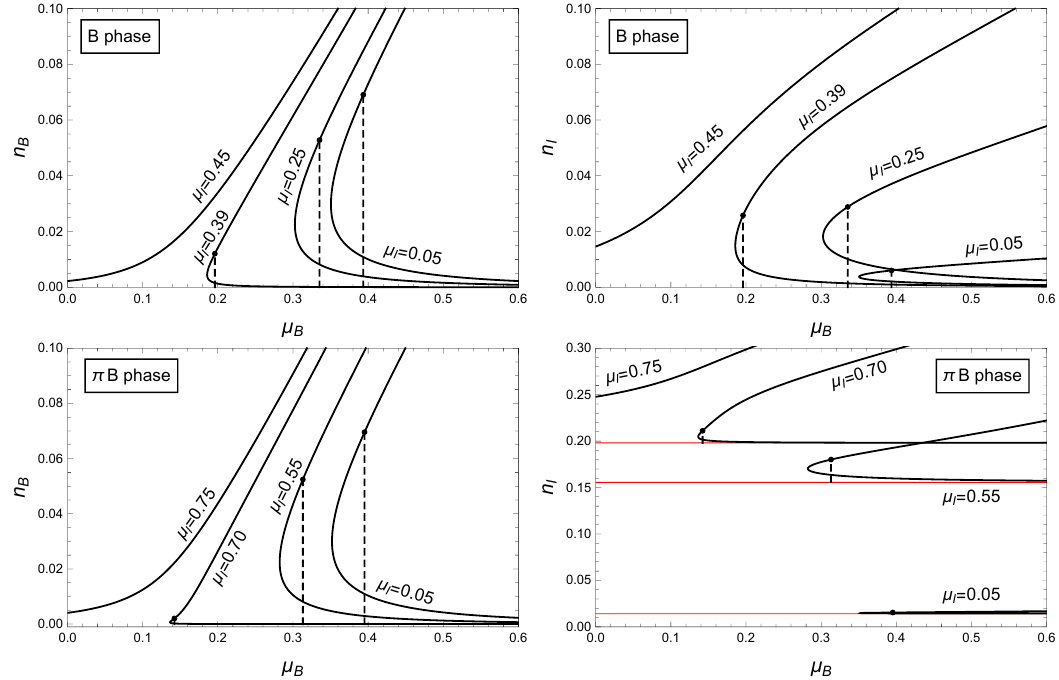
Figure 2: Top row: Dimensionless baryon and isospin number densities n and n in the B I pure baryonic phase as functions of µ at fixed values of the isospin chemical potential µ . B I Dashed lines indicate first-order phase transitions from the vacuum to the B phase, i.e., the branches below the dots are metastable or unstable. Bottom row: Same quantities in the phase where baryonic matter coexists with a pion condensate. The thin (red) lines indicate the values of n in the pure pion-condensed phase, and the dashed lines indicate the transition I from the π phase to the π B phase. All curves are calculated with λ = 15. The dimensionless quantities can be translated into physical units with the help of table 1 and a choice for the Kaluza-Klein scale M KK